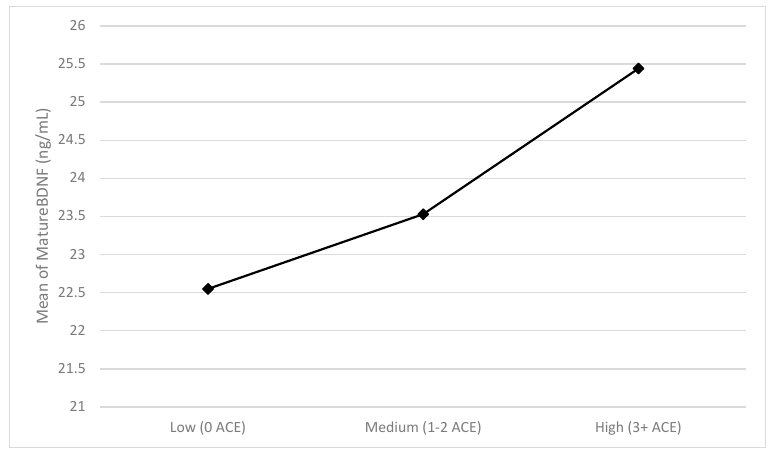
Figure 1. Levels of pro − and mature BDNF across ACEs levels. 3.3. Executive Function and BDNF EF fluid cognition composite scores showed a meaningful positive coefficient that did not reach significance with proBDNF ( β = 0.28, p = 0.100). EF fluid cognition scores showed a smaller positive coefficient that did not reach significance with mBDNF ( β = 0.14, p = 0.406). Again, the magnitude of these effects for proBDNF, especially, could suggest that they may also be detectable and reach significance in a larger sample, suggesting additional study is needed. 4. Discussion The present study advanced the science of ACEs and obesity by simultaneously exam- ining the relationships between ACEs, EF, and BDNF in a pilot sample of women